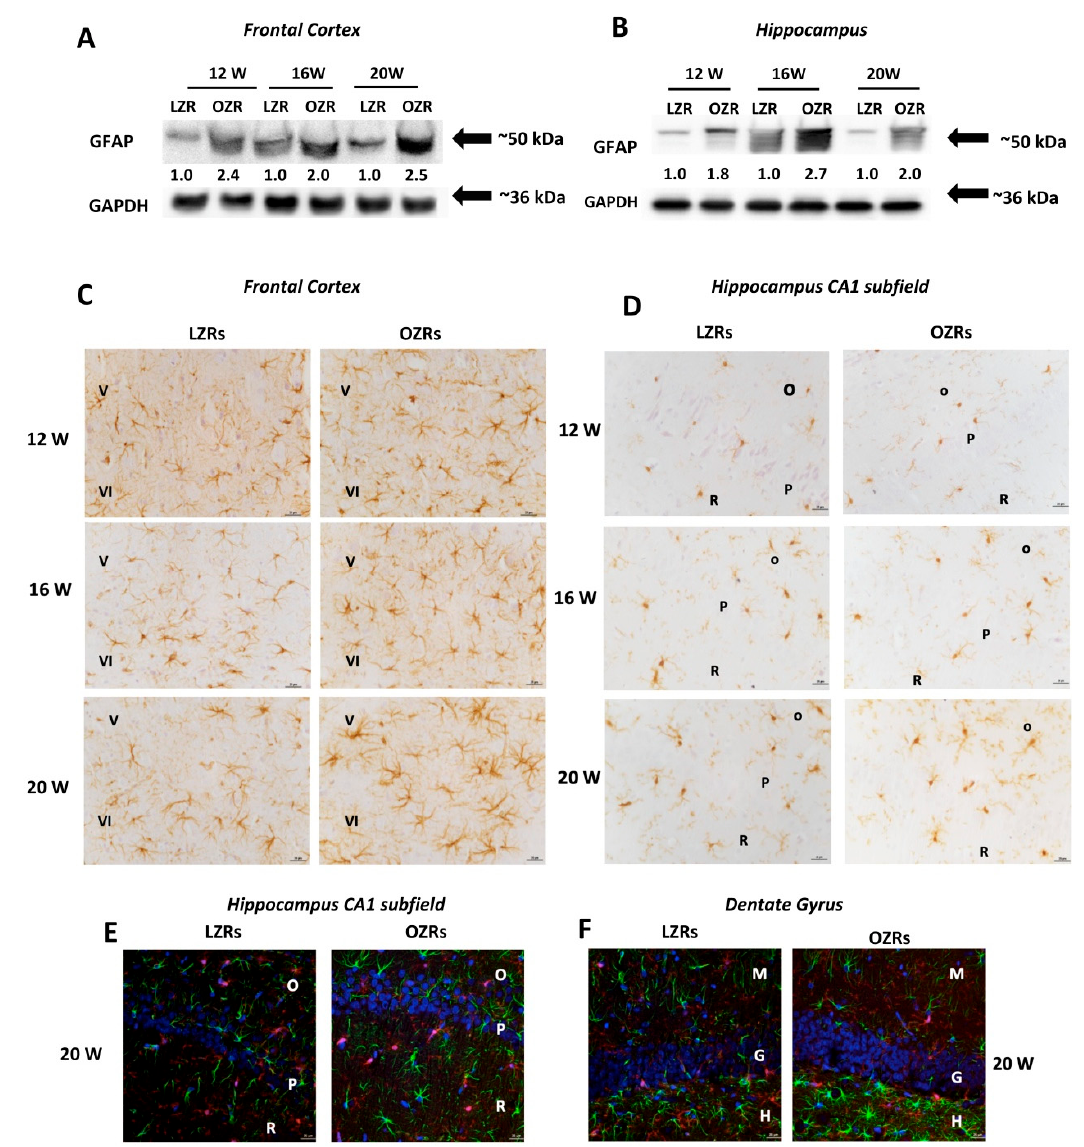
Figure 4. Glial Markers. Immunochemical analysis of the frontal cortex ( A ) and hippocampus ( B ) processed for anti-glial fibrillary acidic protein (GFAP). To investigate more than GFAP protein on the same blot, both membranes of the frontal cortex and hippocampus were stripped and incubated with anti-GAPDH antibody (loading control). Control images are re-used for illustrative purposes. The densitometric analysis of bands is expressed as the ratio between the optical density of protein and reference protein (GADPH) where the value for LZRs of different ages is set as 1. Blots are representative of one of three separate experiments. ( C ) Sections of the frontal cortex of LZRs and OZRs of different weeks of 12-, 16-, and 20-weeks age processed for the immunohistochemistry against the GFAP. V; IV: fifth and sixth layers of the frontal cortex. Magnification 40X. Calibration bar: 25 μ m. ( D ) Sections of the hippocampus (CA1 subfield) of LZRs and OZRs of different weeks of age processed for the immunohistochemistry against ionized calcium-binding adaptor molecule 1 (Iba-1) to detect microglial cells O: stratum oriens ; P: pyramidal neurons; R: stratum radiatum. Calibration bar: 25 μ m. ( E ) Sections of the hippocampus (CA1 subfield) and ( F ) dentate gyrus of 20 weeks-old LZRs and OZRs processed for double immunohistochemistry against Iba-1 (Alexa Fluore 594) and GFAP (Alexa Fluore 488). DAPI was used to counterstain nuclei. O: stratum oriens ; P: pyramidal neurons; R: stratum radiatum . Magnification 40X. Calibration bar: 25 μ m.